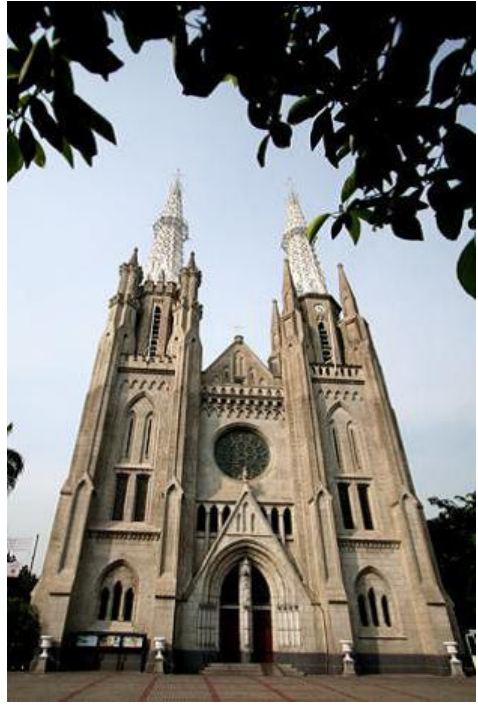
Figure 1. The Jakarta Central